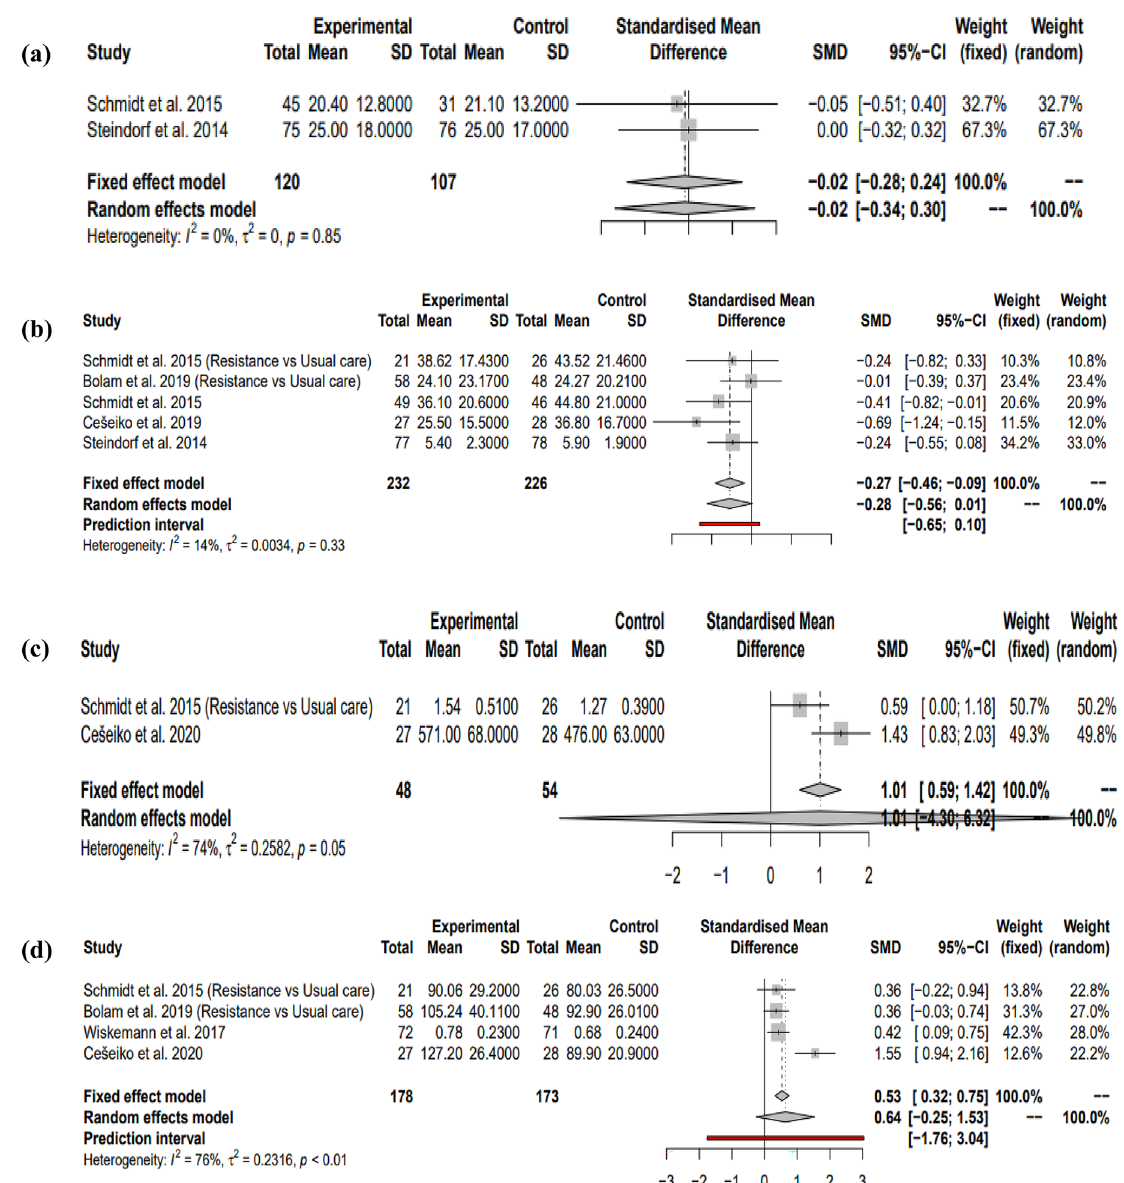
Figure 6. Random effects models showing the effects of resistance interventions on ( b ) global fatigue, ( c ) muscular endurance, ( d ) muscular strength, ( e ) QOL, ( f ) social functioning during adjuvant treatment. Fixed effects model showing the effects of resistance interventions on ( a ) depression during adjuvant treatment. Negative effect sizes favour the exercise intervention in ( a,b ). Positive effect sizes favour the exercise intervention in ( c , d , e,f